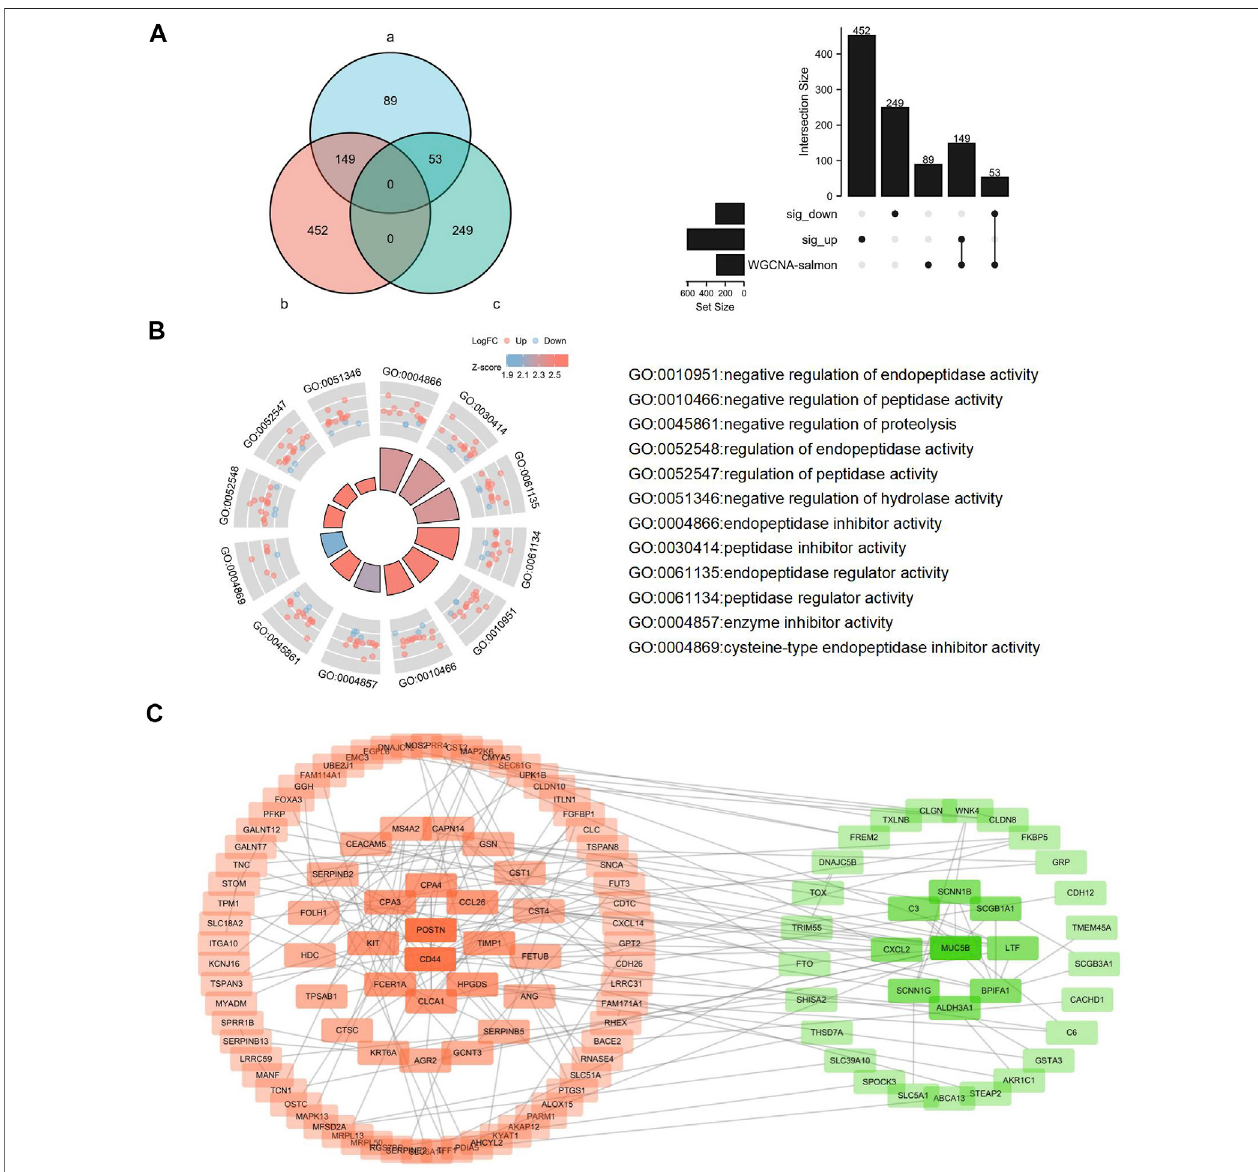
FIGURE 7 | Identi fi cation, functional analysis, and PPI analysis of the DEmRNAs related to Th2 high asthma. (A) Overlapping DEmRNAs were analyzed using the WGCNA-salmonmRNAs,thesigni fi cantlyupregulatedDEmRNAsanddownregulatedDEmRNAs. (B) FunctionalanalysisoftheoverlappingDEmRNAs. (C) PPIanalysis of the overlapping